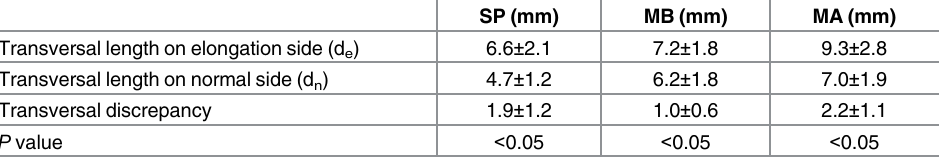
Table 2. Measurement of the transversal discrepancy of asymmetry site in SP, MB, and MA regions after virtual Me point correction. SP (mm) MB (mm) MA (mm) Transversal length on elongation side (d e ) 6.6 ± 2.1 7.2 ± 1.8 9.3 ± 2.8 Transversal length on normal side (d n ) 4.7 ± 1.2 6.2 ± 1.8